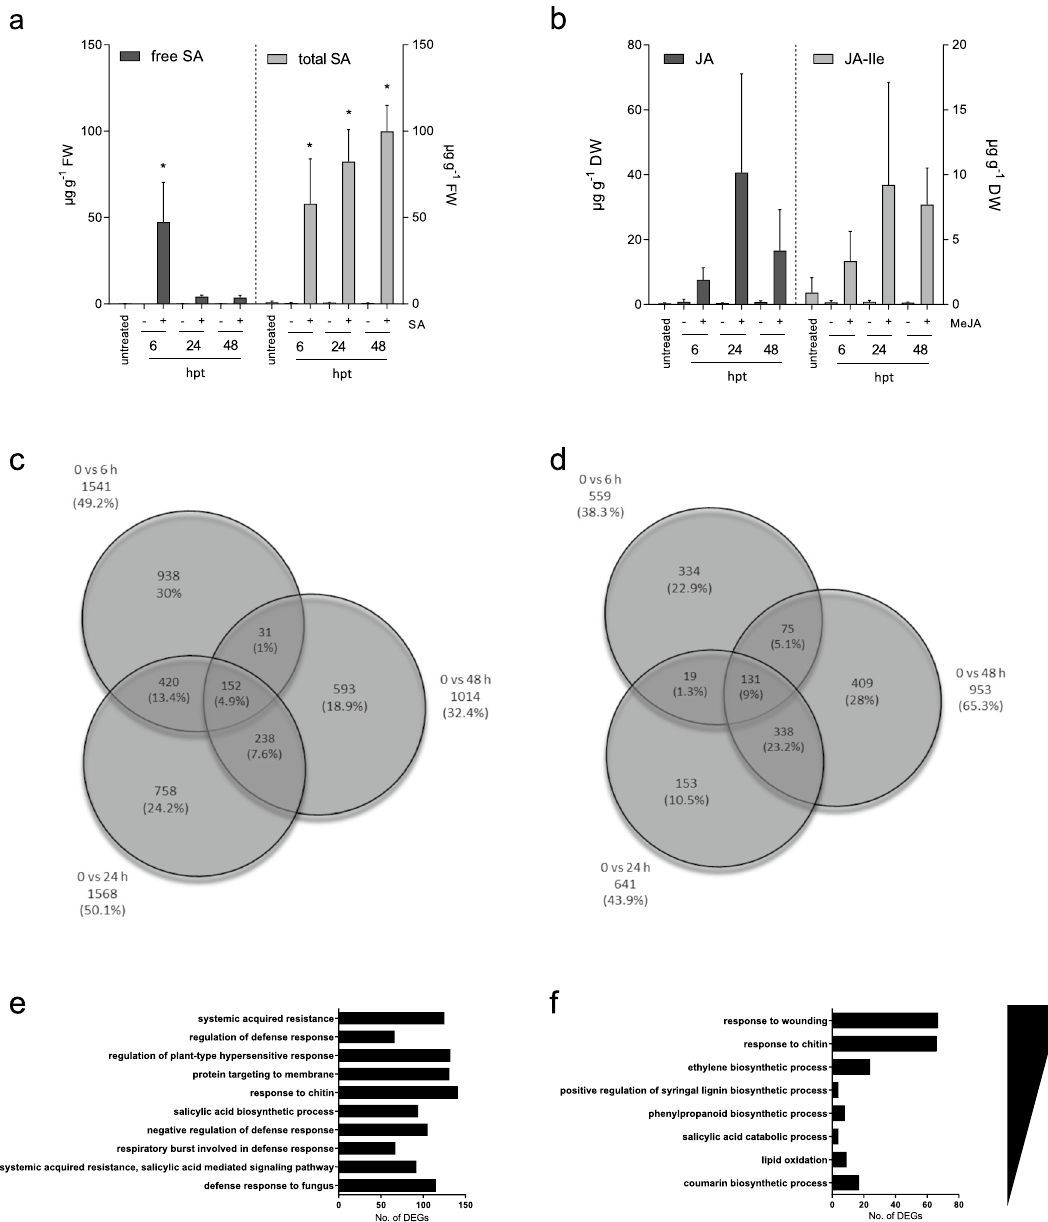
Figure 1. Verification of phytohormone uptake and temporal activation of gene expression. ( a ) Accumulation of free (black bars) and total (grey bars) SA in soybean leaves upon soil drench with water (−) or a 1 mM solution of SA (+) as quantified by HPLC analysis. Average values and error bars of three independent experiments with four individual plants per treatment and experiment are shown. Asterisks indicate significant differences to the adequate untreated control (Dunnett’s multiple comparisons test; p < 0.0001). ( b ) JA (black bars) and bioactive JA-Ile (grey bars) in soybean leaves in the absence (−) or presence (+) of MeJA as determined by LC–MS analysis. Average values and error bars of three independent experiments with three individual plants per treatment and experiment are shown. Significance was calculated by using Dunnett’s multiple comparisons test. No significance differences occurred. ( c , d ) Venn diagrams displaying the number of genes with significantly (p ≤ 0.01) induced expression after ( c ) SA treatment and ( d ) exposure to MeJA compared to the untreated control based on RNA-seq data. In addition to the absolute numbers, the relative amount of induced genes is shown in brackets. Identical samples were used for phytohormone quantification and RNA-seq. ( e , f ) GO terms overrepresented among ( e ) SA-induced ( f ) or MeJA activated genes sorted according to their corrected p-value (Bonferroni correction) (p <